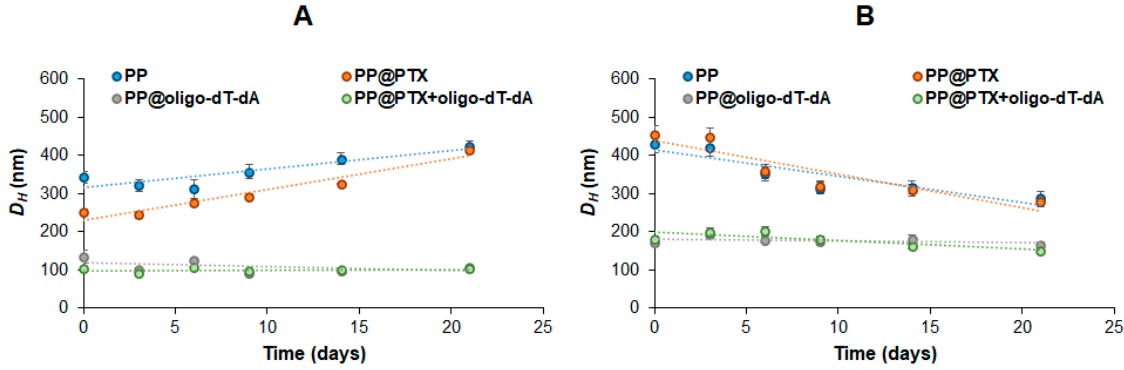
Figure 7. Storage stability of empty nanoparticles, as well as single- and dual-component systems based on P[KK(Y)K(R)] ( A ) and P[KK(Y)K(H)] ( B ) polypeptides, within 3 weeks at room temperature (20 °C, pH 7.4).